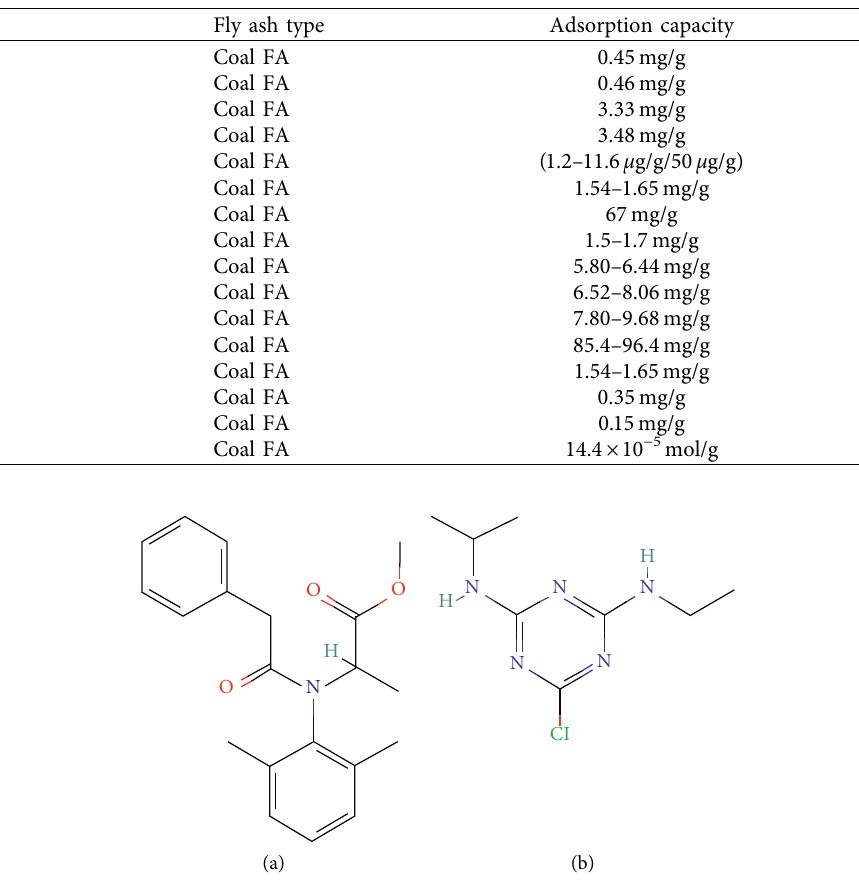
Table 3: Adsorption capacity of coal FA.